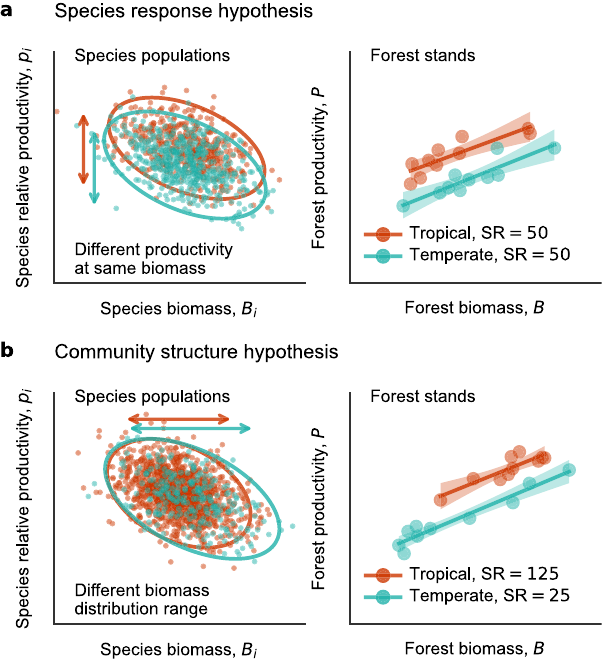
Fig.1|Twohypothesesexplaininghigherforestwoodyproductivityinwarmer forest stands in relation to inter-speci fi c productivity-biomass